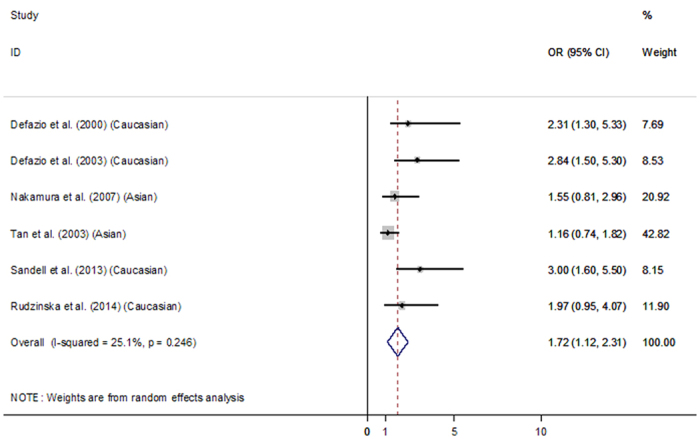
Analysis of pooled published studies.